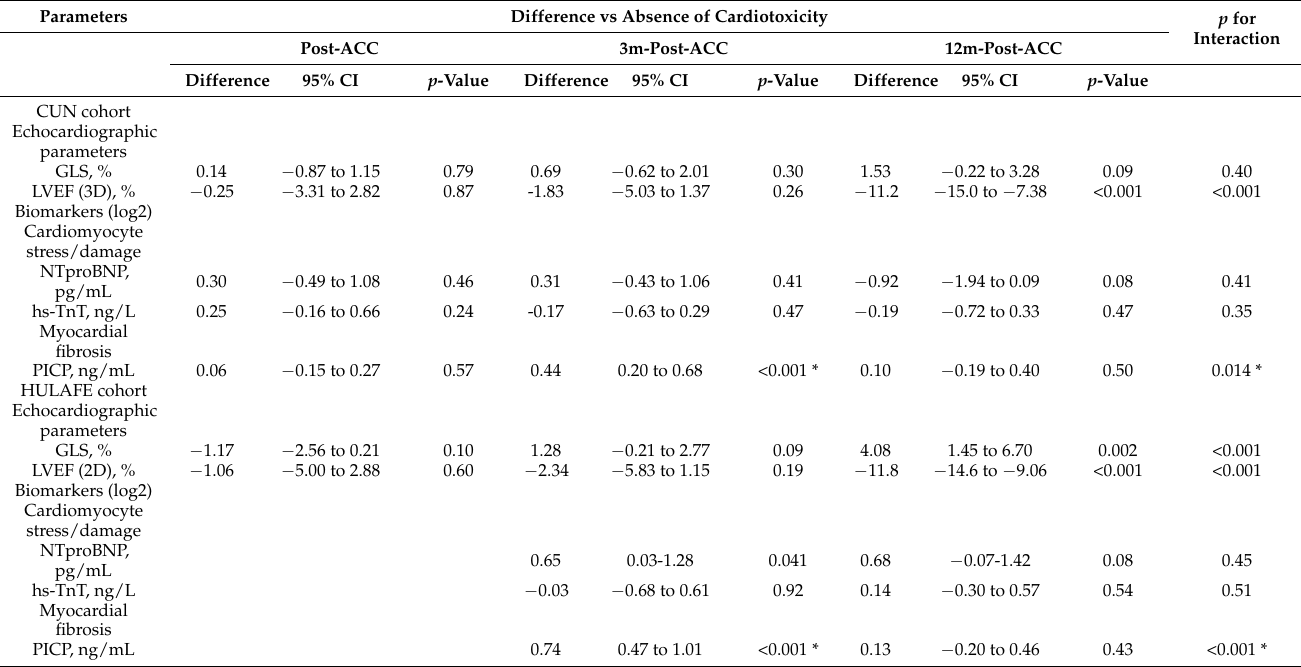
Table 4. Differences in echocardiographic parameters and biomarkers after completion of ACC therapy (post-ACC), 3 months after ACC (3m-post-ACC), and 12 months after ACC (12m-post-ACC) in BC patients with presence versus those with absence of cardiotoxicity at 12m-post-ACC.